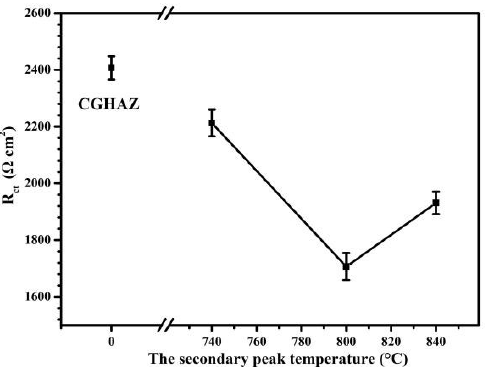
Figure 13. Fitting results of R ct for the CGHAZ and ICCGHAZs with different secondary peak temperatures in 3.5 wt% NaCl solution.